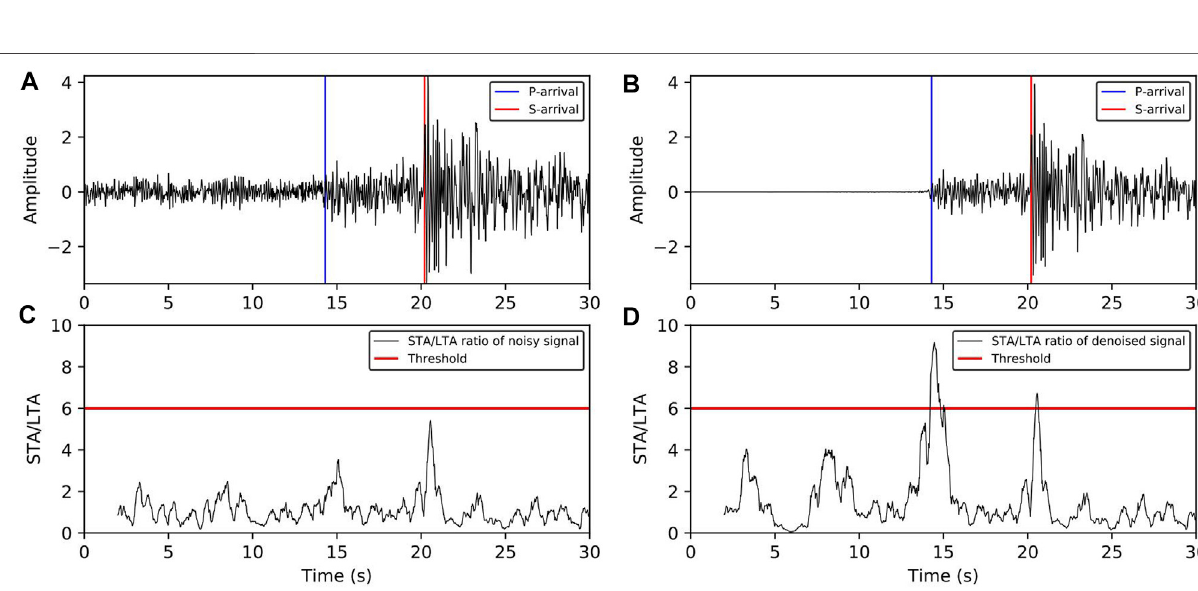
the waveforms of the seismic signals before and after noise reduction, Figure 15C the STA/LTA eigenfunction values of the original signal, and Figure 15D the STA/LTA eigenfunction values of the denoised signal. By comparing the eigenfunction values before and after noise reduction, it can be seen that these are more prominent and easier to identify for the denoised signal of both P and S to time point. Therefore, denoising seismic signals helps to improve the seismic phase identi fi cation ability of the algorithm. In order to test the practical